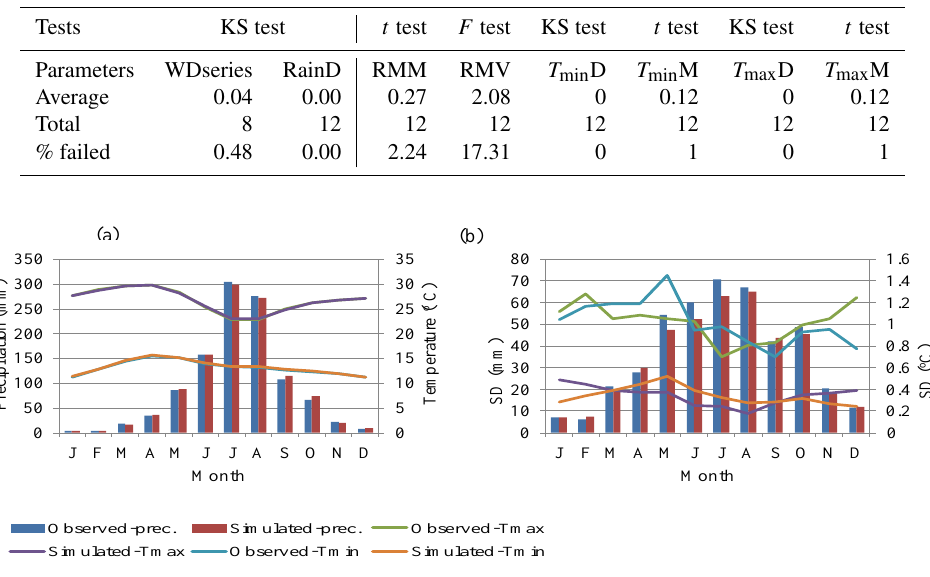
Figure 3. Observed and simulated (a) mean monthly precipitation, T max and T min ; (b) standard deviation of precipitation, T max and T min using